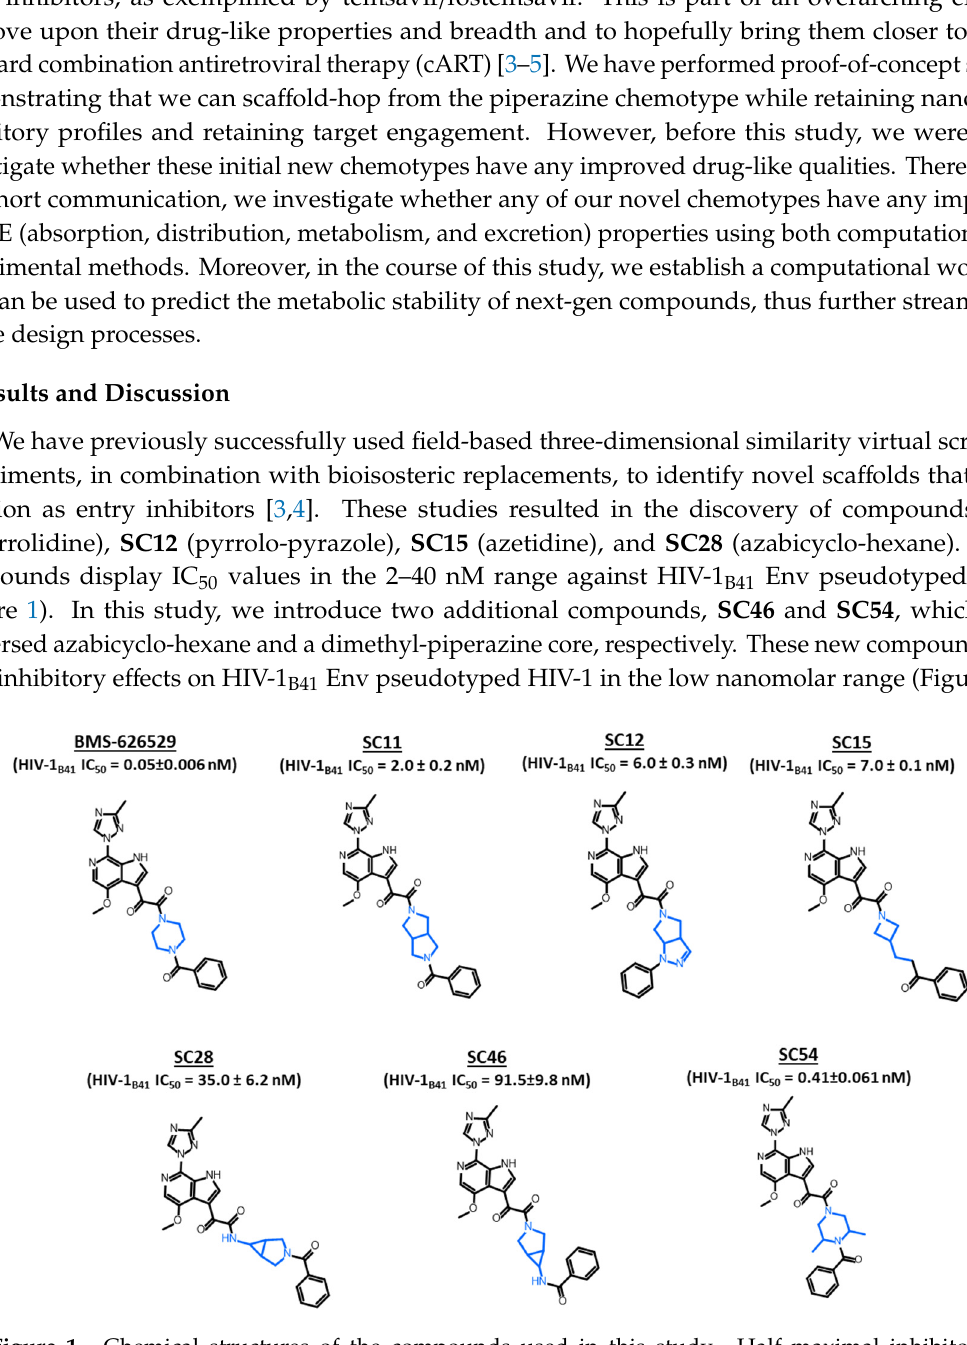
Figure 1. Chemical structures of the compounds used in this study. Half maximal inhibitory concentrations (IC 50 ) against HIV-1 B41 Env pseudotyped HIV-1 are given. Structural differences in the core regions are highlighted in blue. The chemical structures were drawn with ChemAxon software (Budapest, Hungary).